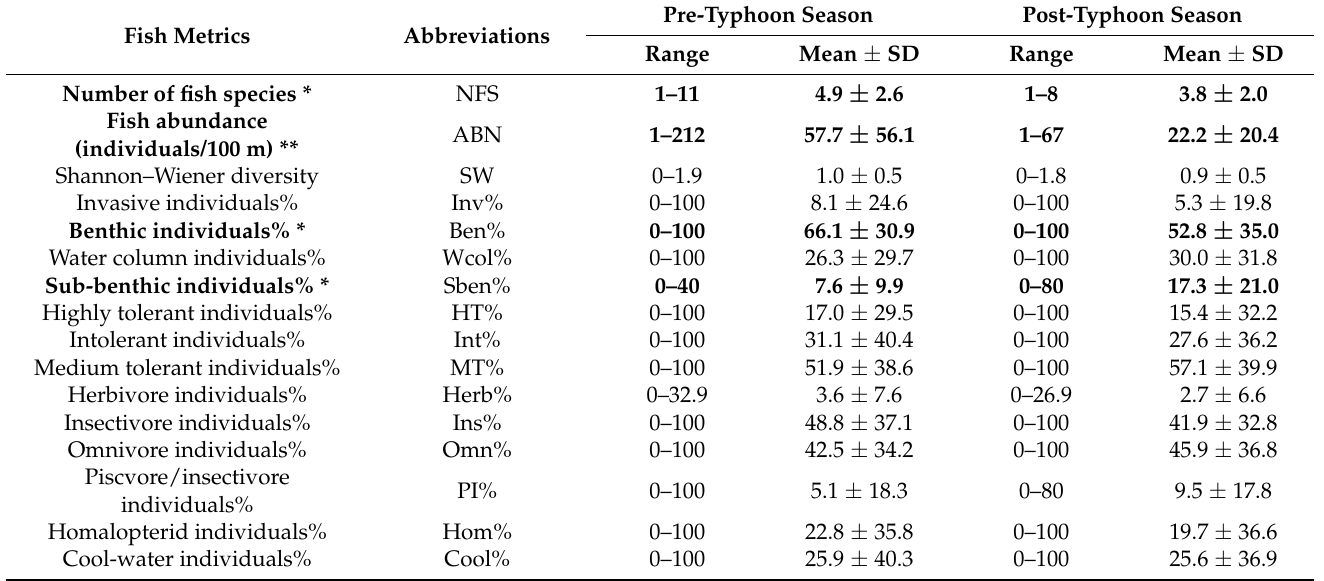
Table 1. The range, mean, and standard deviations of fish community metrics. ** = significant at p < 0.01 and * = significant at p < 0.05 by paired t -tests between two seasons (also indicated in